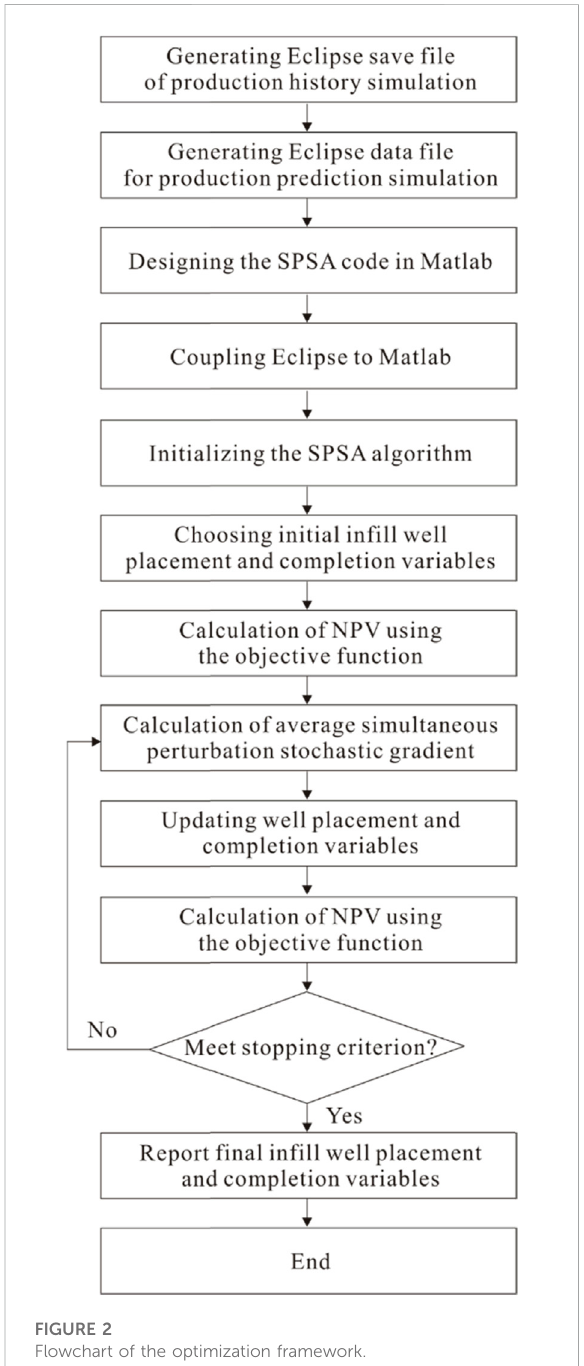
FIGURE 2 Flowchart of the optimization framework.